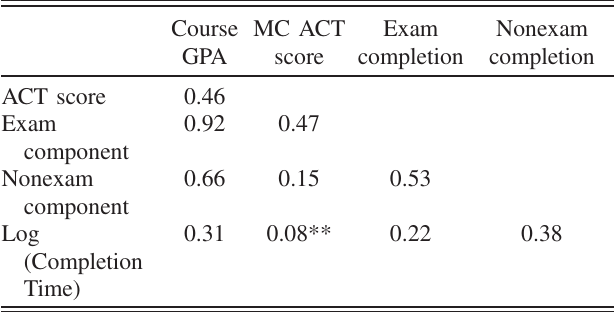
TABLE II. Correlations between grades, grade component scores, ACT score, and the log of the student ’ s mean completion time. Note: All values are significant at 0.001 level, except for one cell marked **=significant at the 0.01 level.